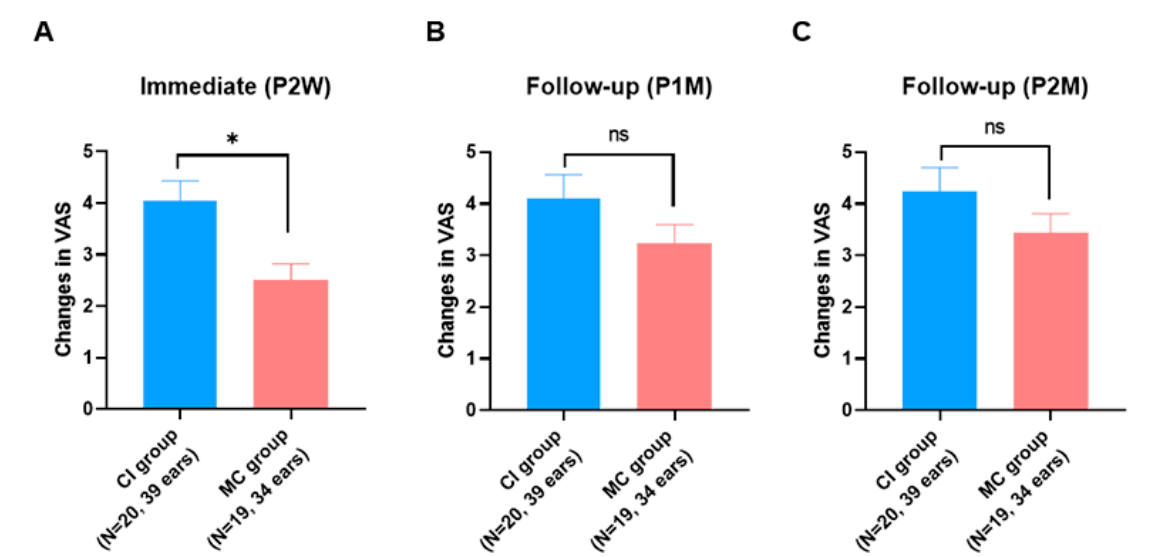
Figure 3. Comparison of subjective improvement of itching sensation at each time point between the two groups. ( A )Two weeks post treatment. ( B ) One month post-treatment ( C ) Two-months post-treatment. CI, topical calcineurin inhibitor; MC, moisturizing cream; VAS, visual analog scale; P2W, post-treatment two weeks; P1M, post-treatment one month; P2M, post-treatment two months; *, statistically significant ( p < 0.05); ns, not significant.